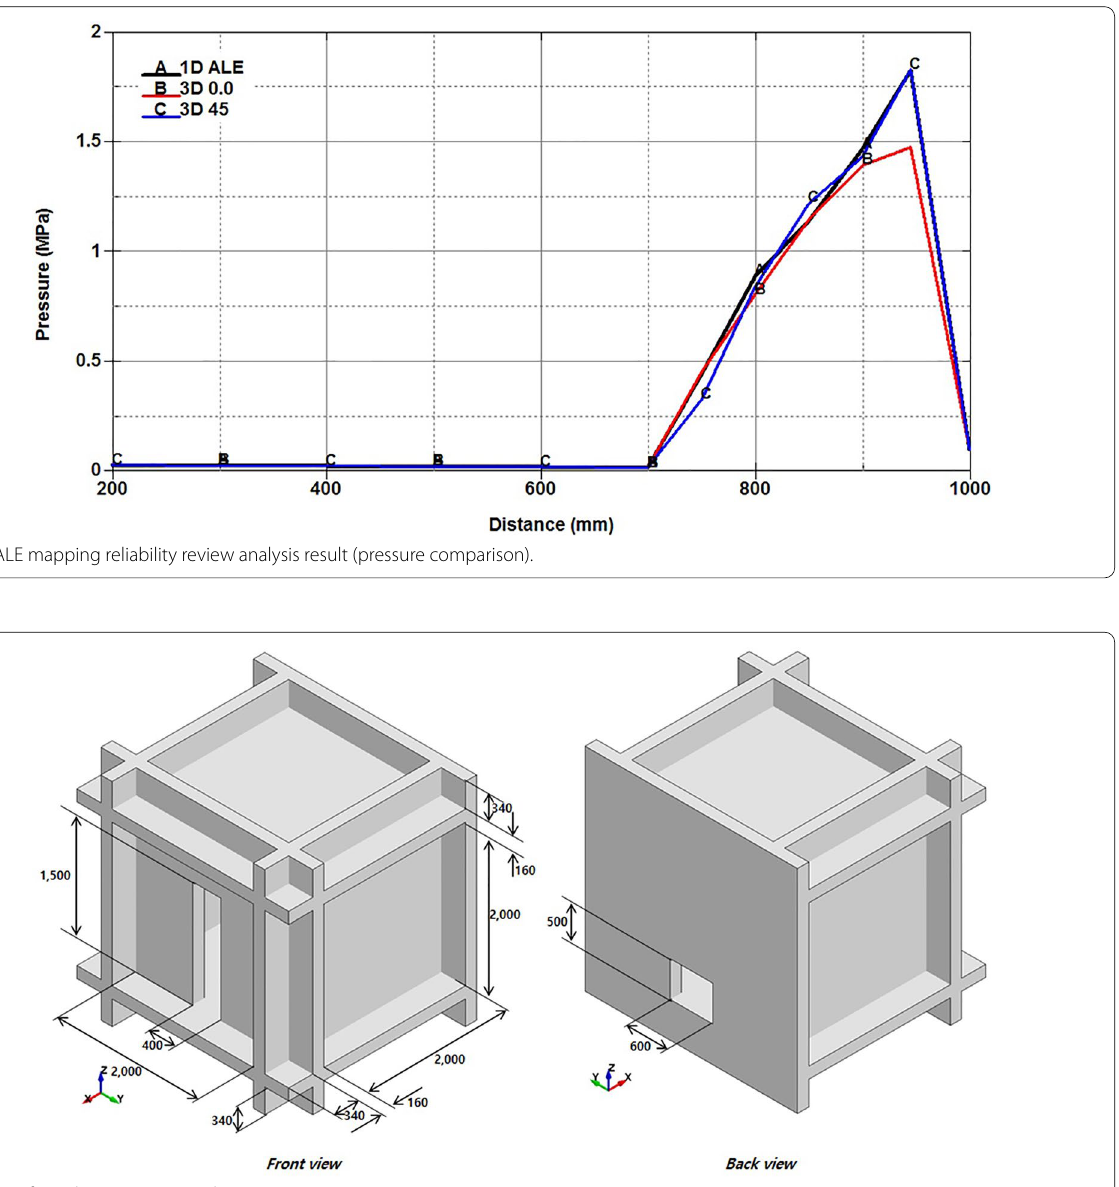
Fig. 15 Reinforced concrete room